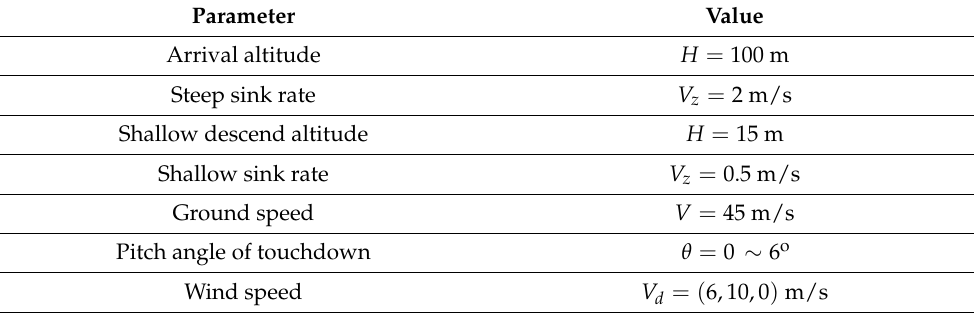
Table 2. Performances of standard track.